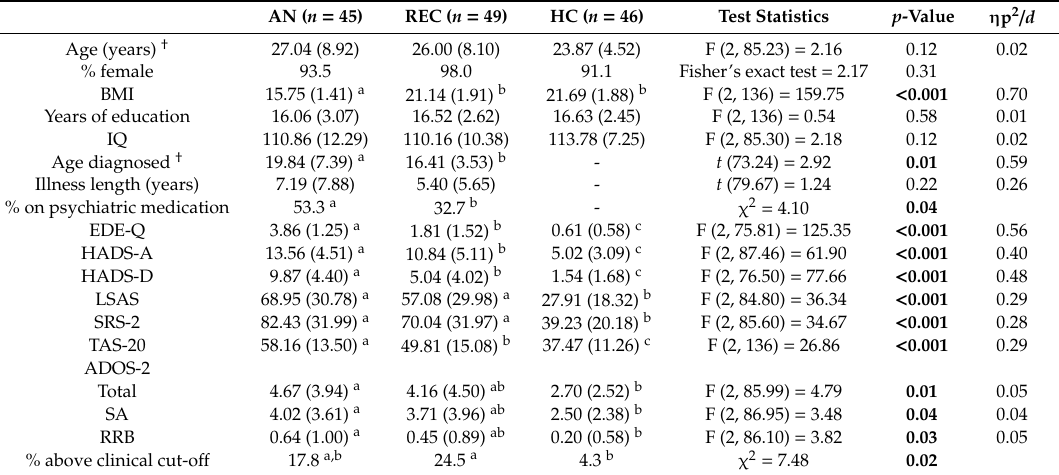
Table 1. Mean (SD) demographic information and psychopathology